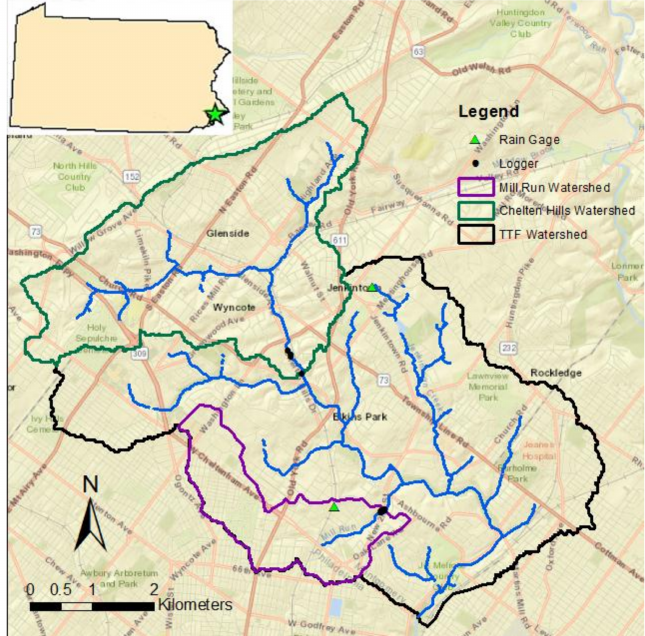
Figure 1. Tookany Watershed and PA state map inset: The Tookany Watershed (black) is 41.6 km 2 and is primarily classified as low intensity residential development. Two sub watersheds, Chelten Hills (green) and Mill Run (purple) were monitored using turbidity loggers. There were eight logger locations in the watershed.